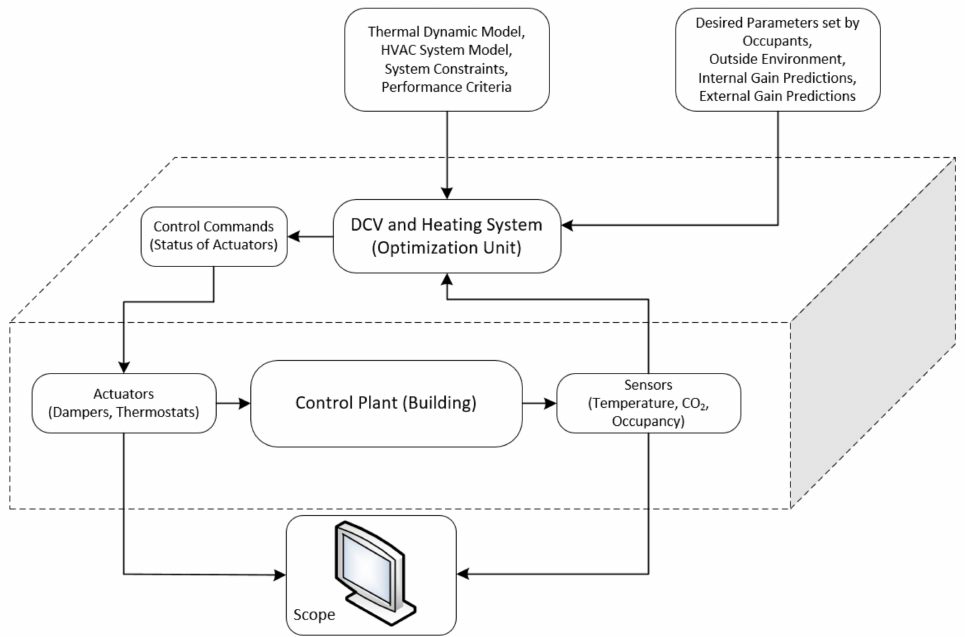
Figure 3. Role of DCV and heating system in optimizing the